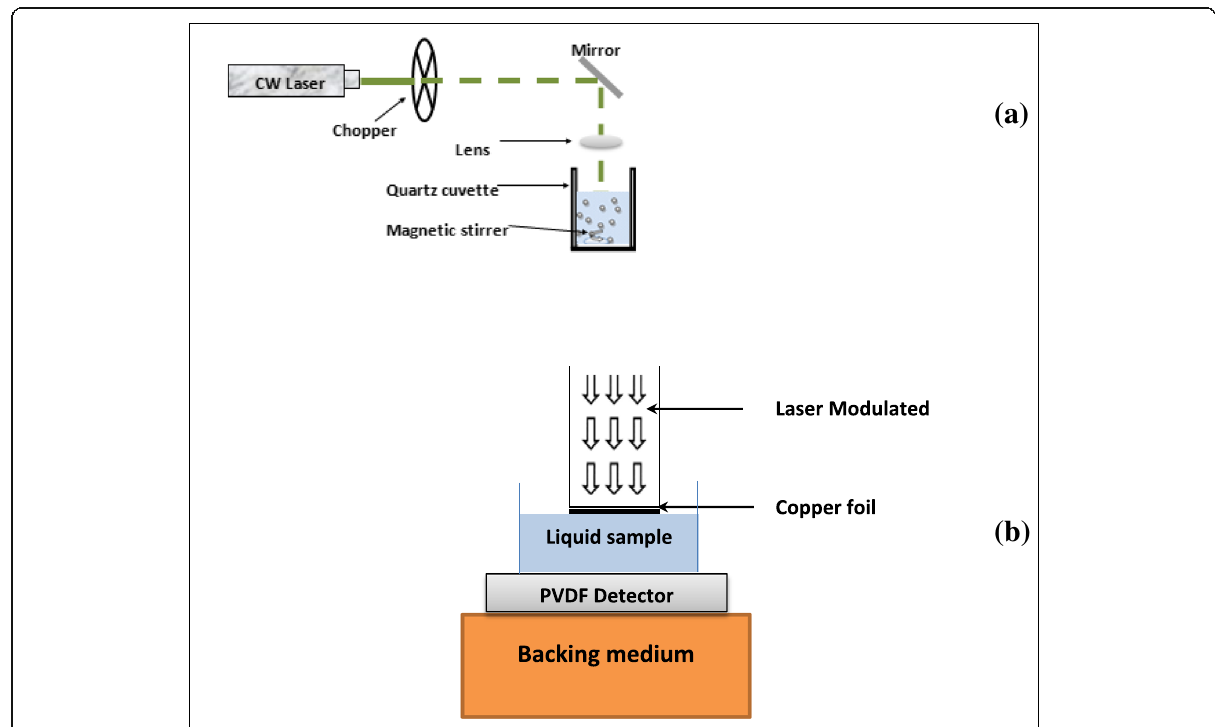
Fig. 3 a Block diagram of experimental setup used in fragmentation of particles by a modulated CW laser beam and b schematic view of the photopyroelectric (PPE) configuration detection cell for thermal diffusivity